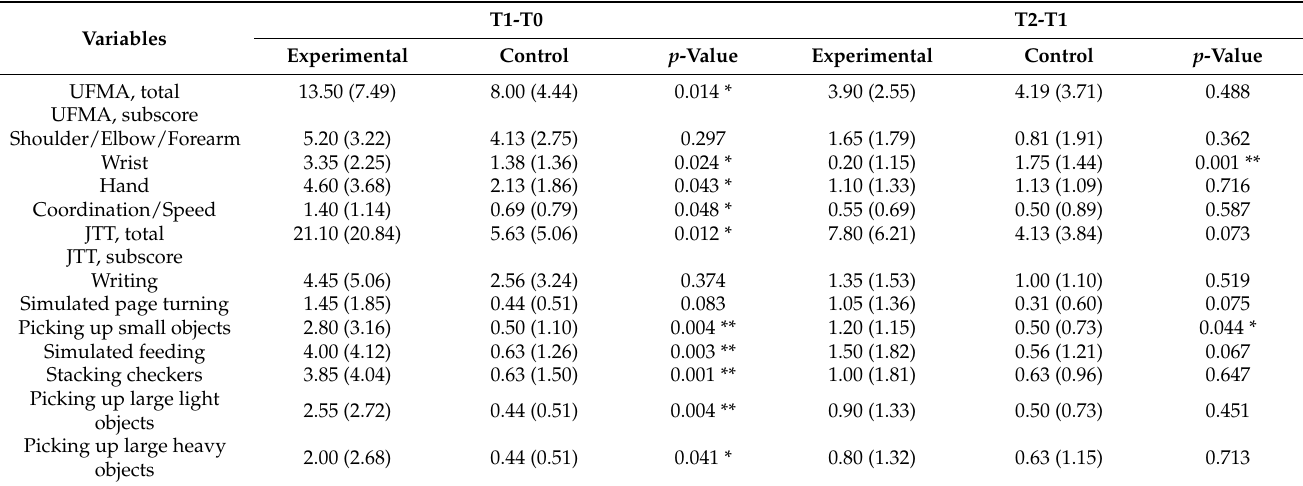
Table 3. Changes in assessment scores for the affected upper extremity in the experimental and control